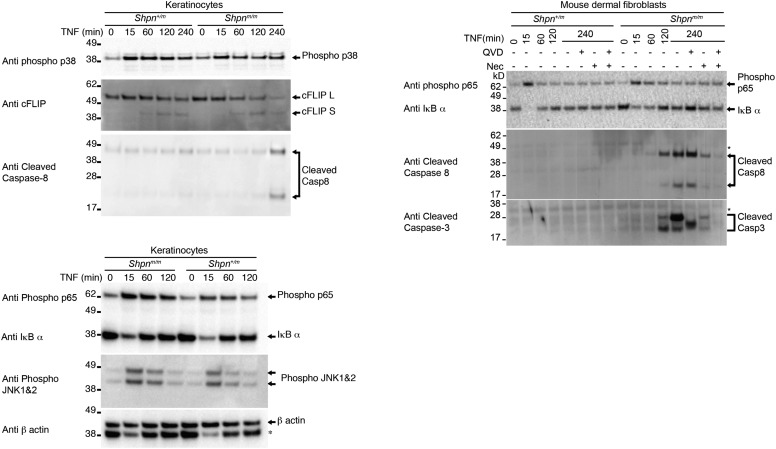
TNF induces caspase-3 and -8 cleavage in primary keratinocytes and mouse dermal fibroblasts in vitro.Western blot analysis of primary keratinocytes and mouse dermal fibroblasts (MDFs) treated as indicated (reagent concentrations as per Figure 4A,B) then lysed and lysates separated on SDS/PAGE and western blotted with indicated antibodies. * Indicates non-specific band. Lysates generated from different mice to those shown in Figure 4.